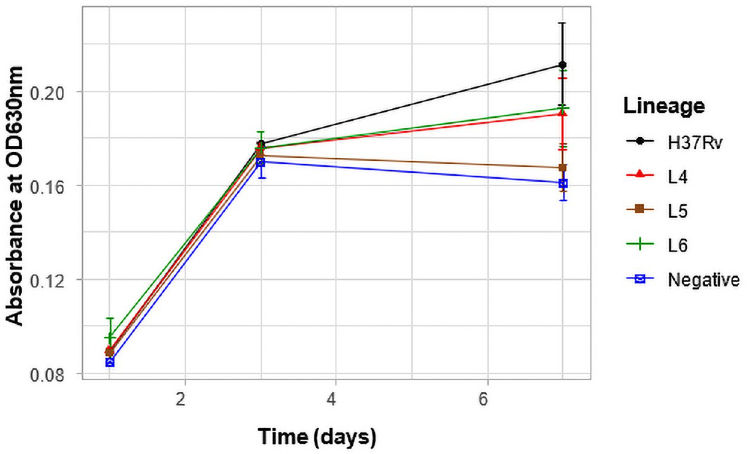
Fig 7. Comparison of urease activity of the three different lineages. A negative control depicted by the blue line was only urea broth. H37Rv was included in the experimental set-up as a positive control (black line).